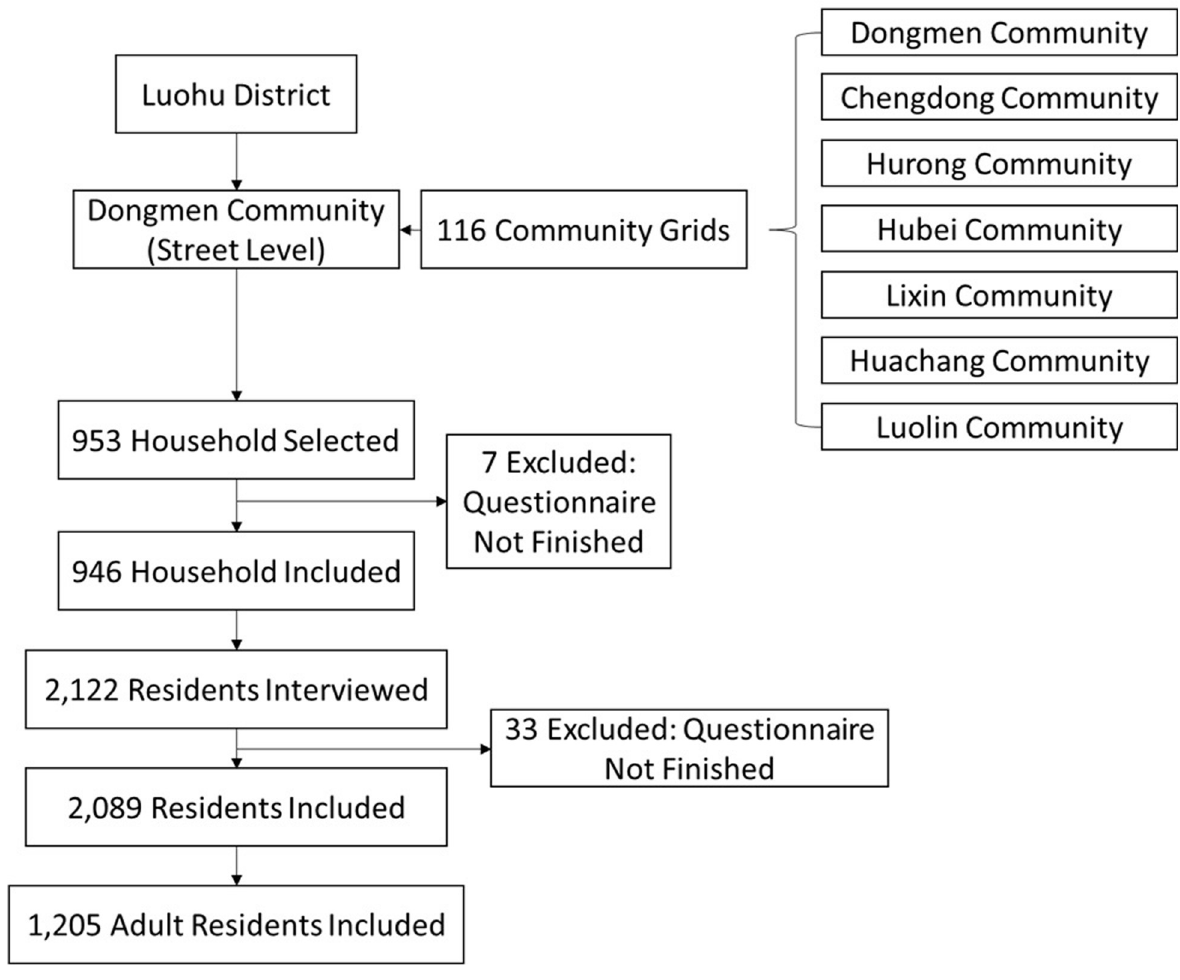
Fig 1. Participants recruitment